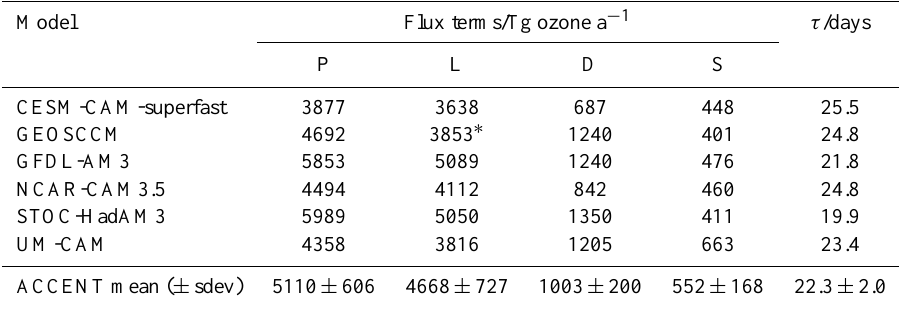
Table 2. Tropospheric ozone budget statistics for a subset of ACCMIP models for the Hist 2000 time slice, showing chemical production (P), chemical loss (L), deposition (D), the inferred stratospheric influx (S), and the lifetime ( τ ).